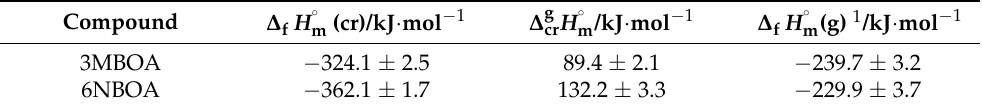
Table 3. Experimentally derived standard ( p ◦ = 0.1 MPa) molar enthalpies of formation, in the gaseous phase, at T = 298.15 K, for the compounds studied.